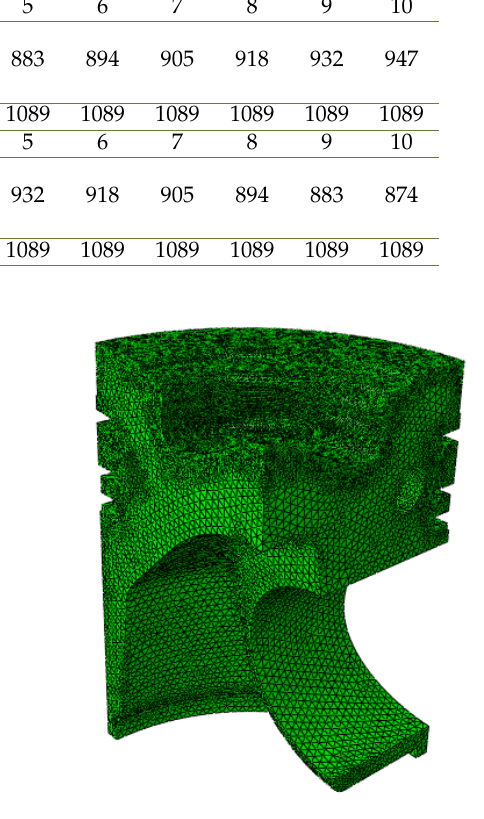
Fig. 4. Finite element